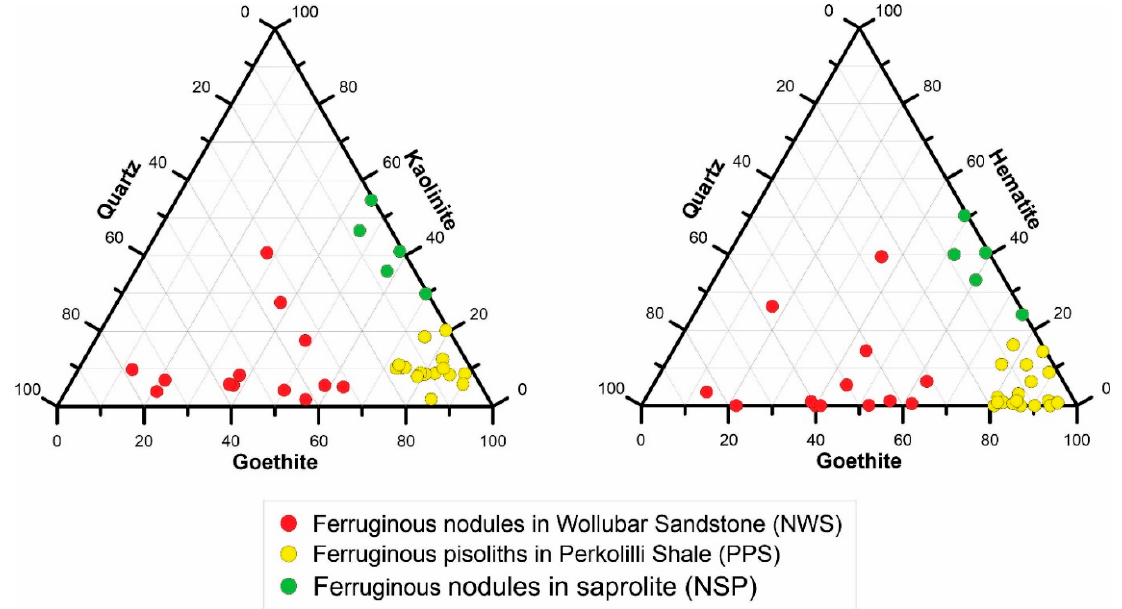
Figure 9. Ternary diagrams showing composition of ferruginous nodules and pisoliths in terms of goethite, hematite and quartz and goethite, kaolinite and quartz.